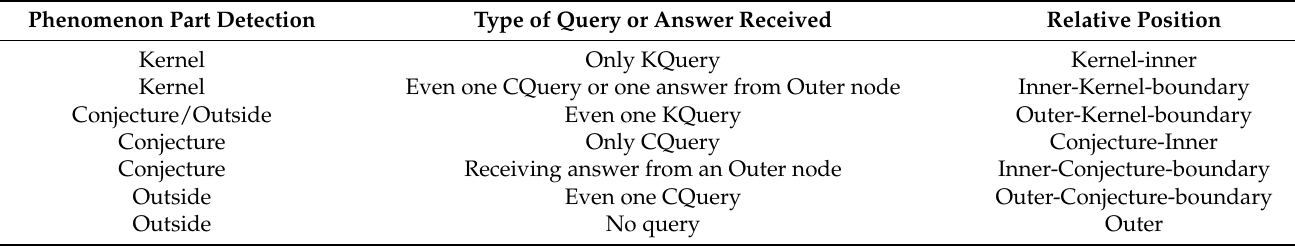
Table 2. Relative position of nodes according to parts of the monitored phenomenon.